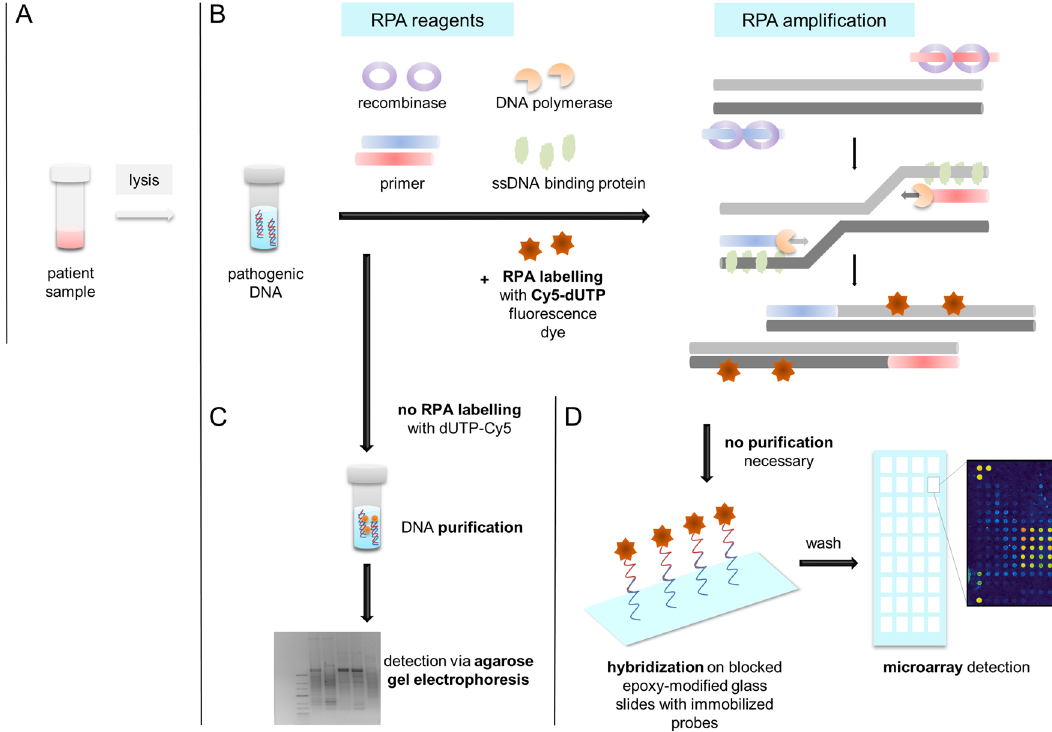
Figure 1. Overview of the experimental workflow. Pre-preparation and extraction of the DNA ( A ) are not included in this study. ( B ) For the amplification of the pathogenic DNA, recombinase polymerase amplification (RPA) was performed using Cy5-dUTP for labelling of the products. ( C ) After the RPA the amplicons has to be purified for detection and validation via agarose gel electrophoresis. ( D ) For the hybridization and subsequent microarray detecting of the pre-labelled amplicons, no purification is necessary. This step was performed using immobilized probes on epoxy-modified glass